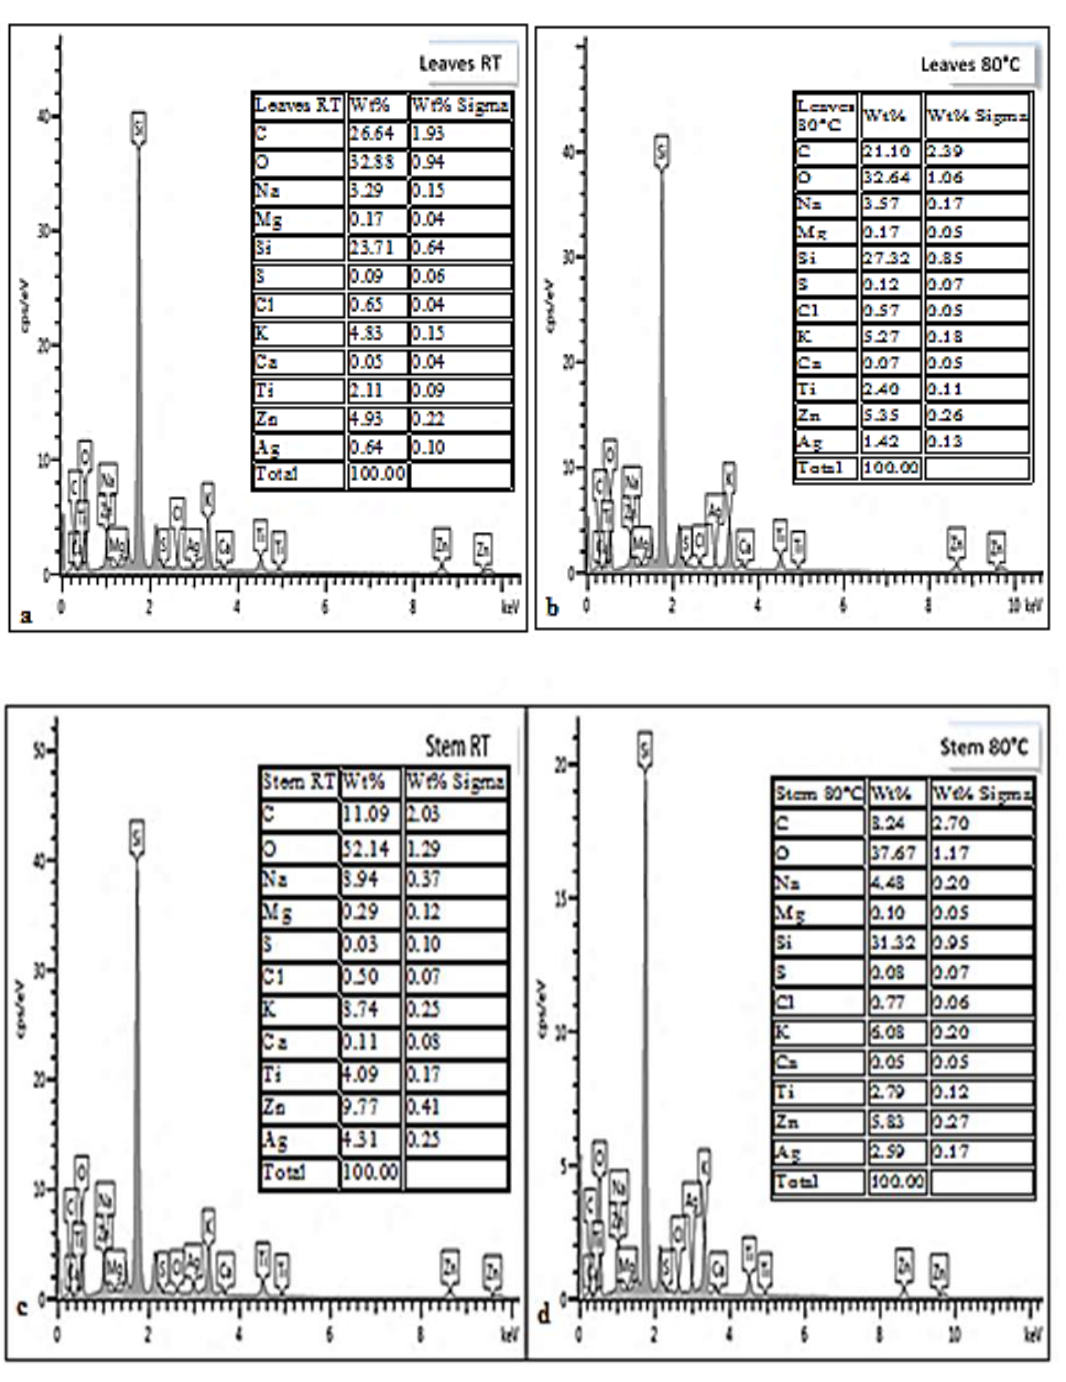
Figure 5. EDX spectra of D. villosa leaves AgNPs synthesized at room temperature ( a ), at 80 °C ( b ) and D. villosa stem bark AgNPs synthesized at room temperature ( c ) and at 80 °C ( d ), respectively.